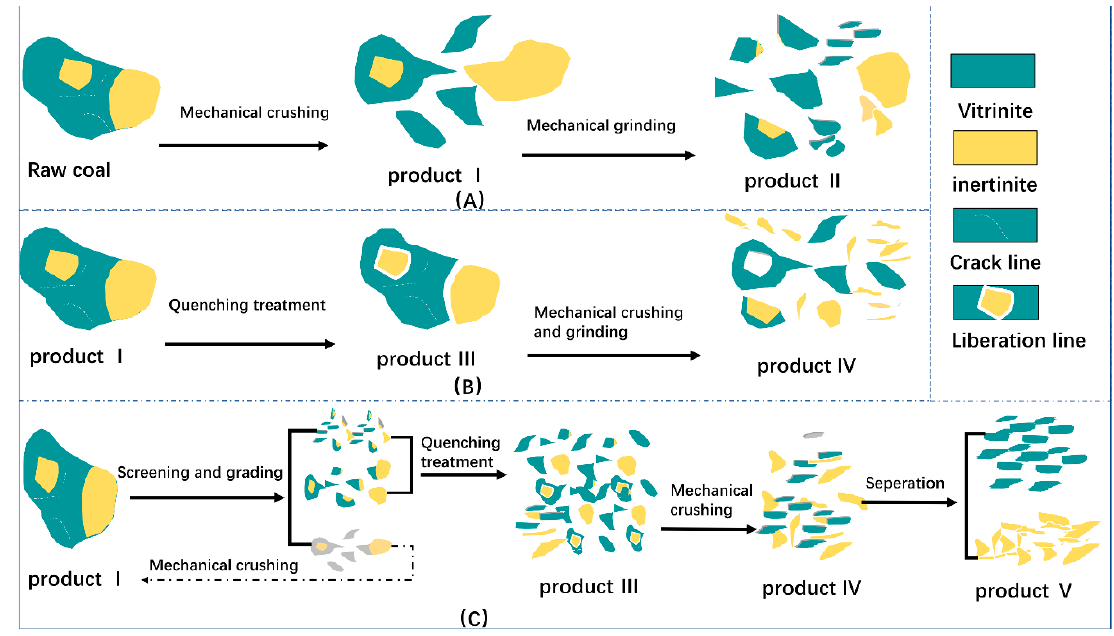
Figure 12. Model of the liberation and optimization of macerals from coal. Product Ⅰ : products from the primary crushing of raw coal; Product Ⅱ : product obtained by crushing product Ⅰ (the product without quenching with liquid nitrogen); Product Ⅲ : product obtained by quenching product Ⅰ with liquid nitrogen; Product Ⅳ : product obtained from the grinding of product Ⅲ (products obtained by quenching with liquid nitrogen); and Product Ⅴ : single maceral obtained by separation treatment. ( A ) A maceral liberation model under the action of common mechanical crushing and grinding methods; ( B ) A maceral liberation model under quenching pretreatment; ( C ) A optimized macerals liberation model.